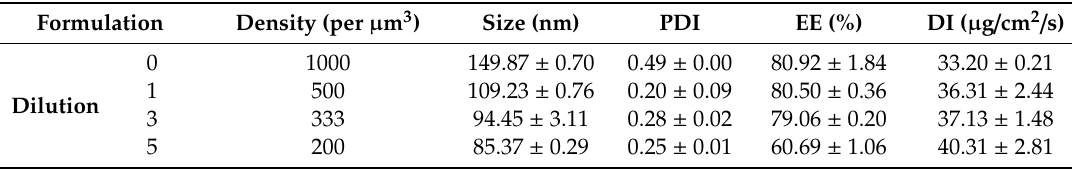
E ff ect of di ff erent density of nanovesicles on the size, PDI, entrapment e ffi ciency, and deformability index of IPC-DNVs after lyophilization ( n = 3). Formulation